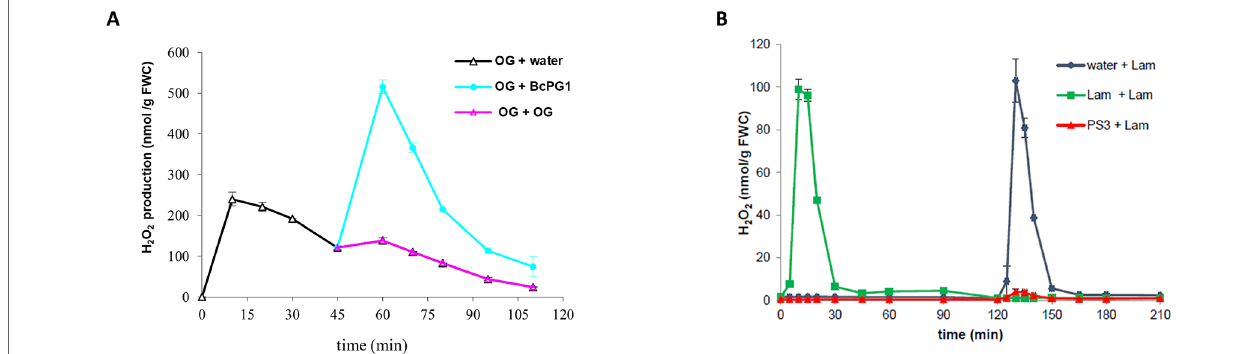
FIGURE 2 | Desensitization experiments can differentiate MAMPs/DAMPs perceived by independent or common receptors in grapevine. (A) Desensitization experiments reveals that BcPG1 and OGs are perceived differently by grapevine cells as the H 2 O 2 production is abolished after two successive treatments with OG (pink) but not when BcPG1 (cyan) succeeds to a first treatment with OGs (black). Cells were first treated at time 0 with OGs (200 µg/ml; black), washed three times between 30 and 45 min with fresh medium, then treated a second time with OGs (200 µg/ml; pink), BcPG1 (0.2 µg/ml; cyan), or water (black). H 2 O 2 production was determined using chemiluminescence of luminol as described by Poinssot et al. (2003). (B) Refractory state experiments revealed that the two β -glucan derivatives (PS3 and Lam) might be perceived by the same receptor in grapevine cells as a first treatment with PS3 abolishes the oxidative burst normally elicited by laminarin. Cells were first treated at time 0 with water (black), laminarin (Lam, 4 mg/ml; green), or PS3 (4 mg/ml; red); washed three times between 90 and 120 min with fresh medium; and then treated a second time with laminarin (4 mg/ml). H 2 O 2 production was determined using chemiluminescence of luminol as described by